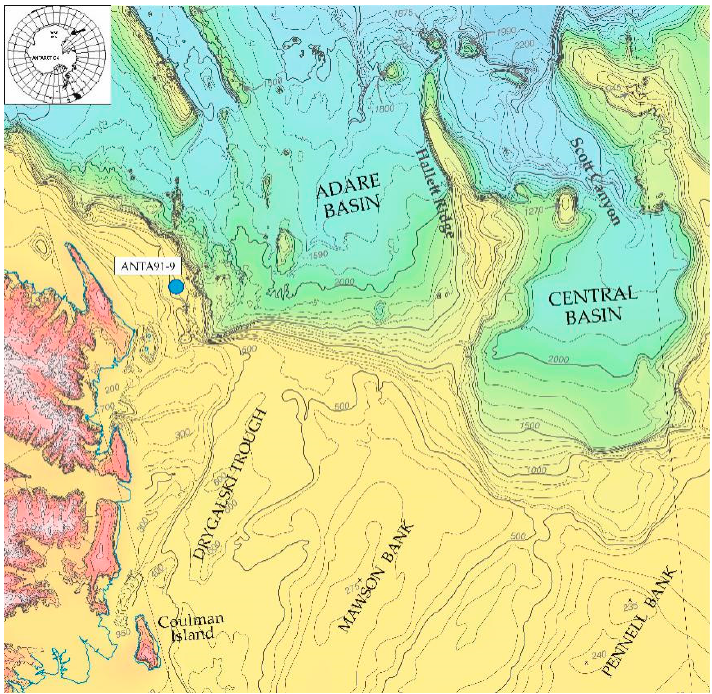
Figure 1. Location of the ANTA91-9 core. Ross Sea bathymetric map (after [26]), modified, showing the location of the named basins and banks.